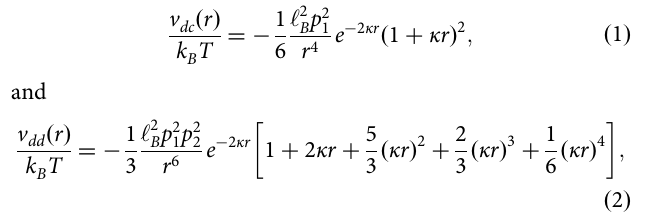
effective dielectric constant of the medium), and κ is the inverse Debye length 43 .